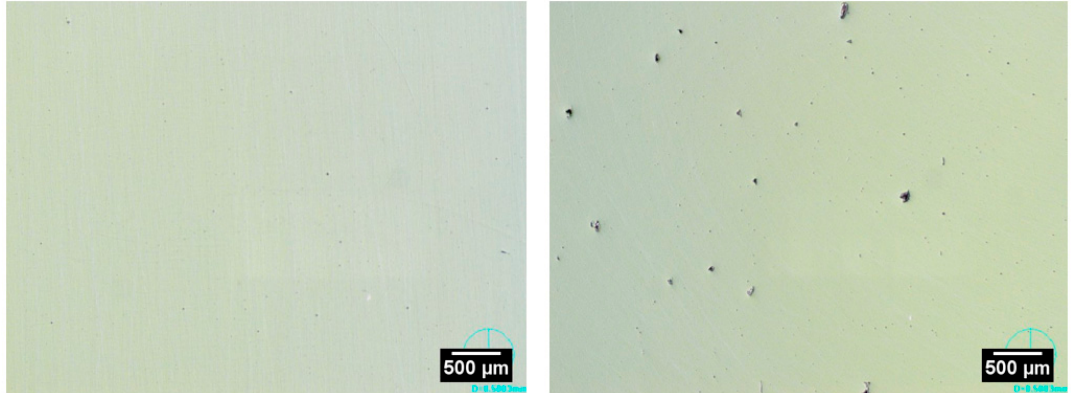
Figure 27. Residual defect, company C: XY face ( left ), XZ face ( right ).